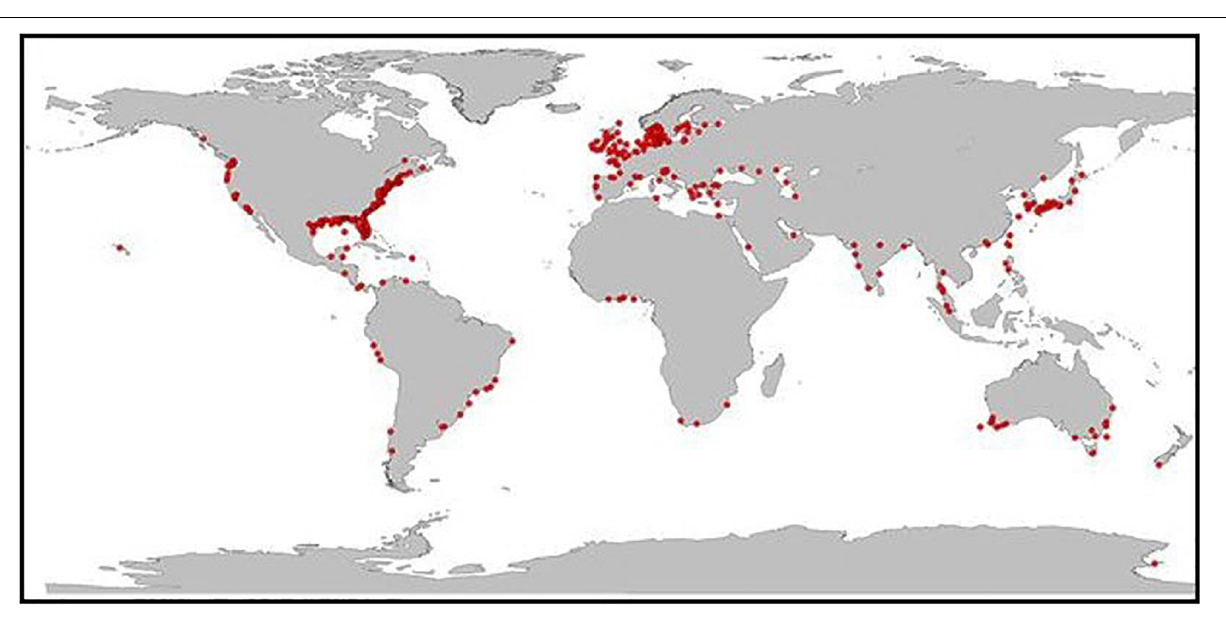
(6%) (Lu and Tian, 2017). Volatilization of ammonia from agriculture fields emits an estimated 10 × 10 9 kg N yr − 1 (8% of the N applied) into the atmosphere (Vitousek et al., 1997; Bouwman et al.,